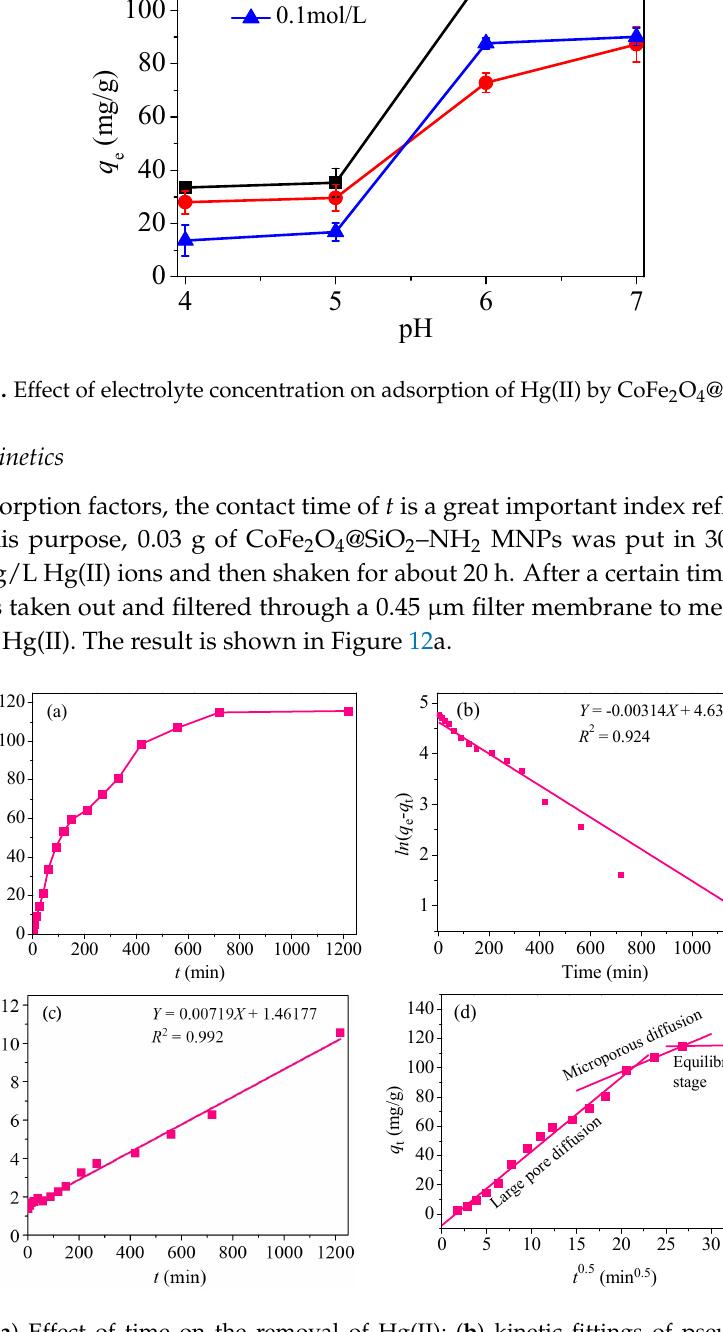
Table 2. Kinetic model fitting parameters. Pseudo-First-Order